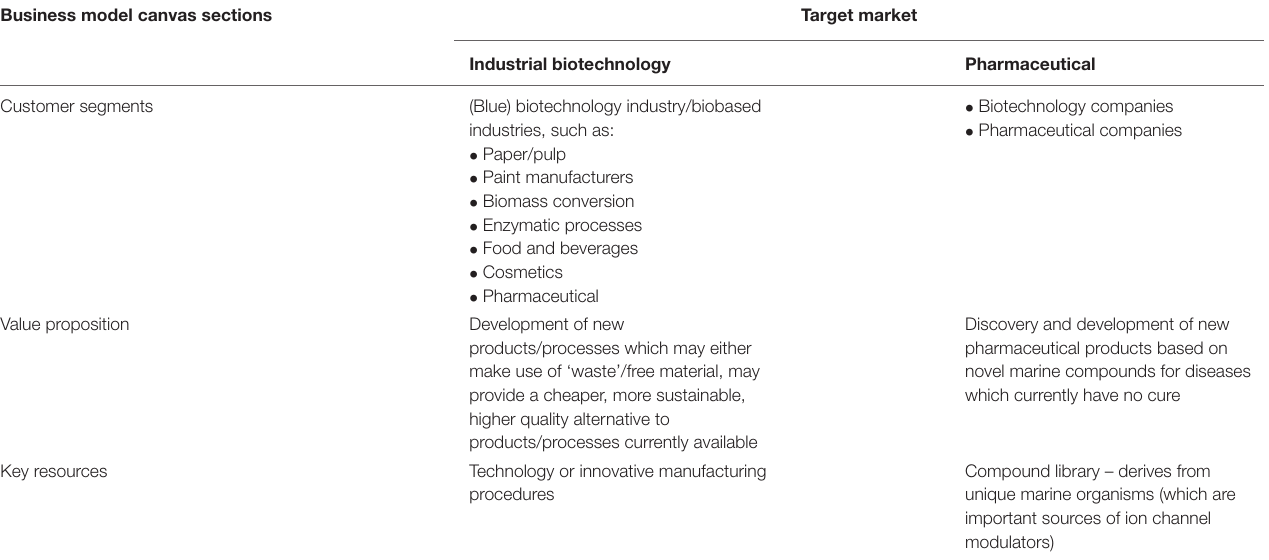
FIGURE 7 | A Business Model Canvas representing the current, “typical” model used my marine bioresource start-ups/SME’s. Green boxes indicate sections of the business model which were very similar for all organizations interviewed. Blue boxes indicate sections which were different but with some similarities, and the red box indicates the section which was very different for all organizations interviewed. The bold, numbered boxes represent areas with potential for improvement, where implementable actions could be considered and applied. TABLE 2 | The business model canvas of seven organizations interviewed in this study were grouped according to target end market, namely the industrial (algae-based) biotechnology sector versus the pharmaceutical